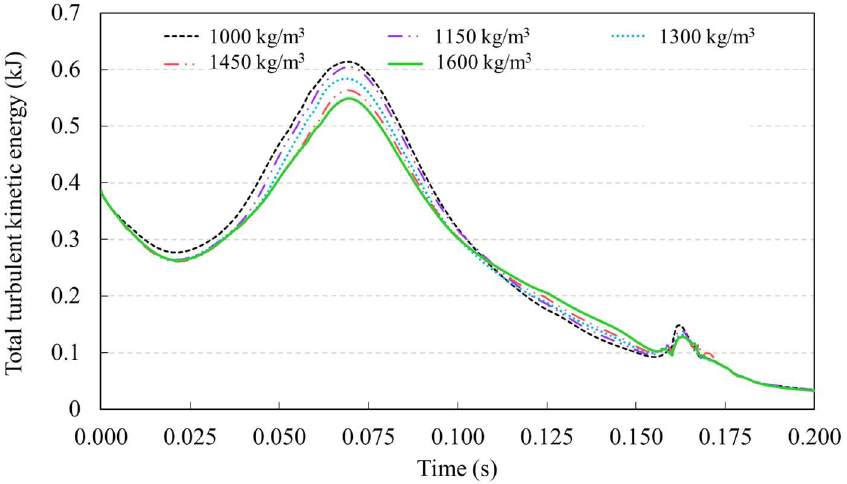
Figure 10. Total turbulent kinetic energy in one operation cycle with time and with different liquid densities.